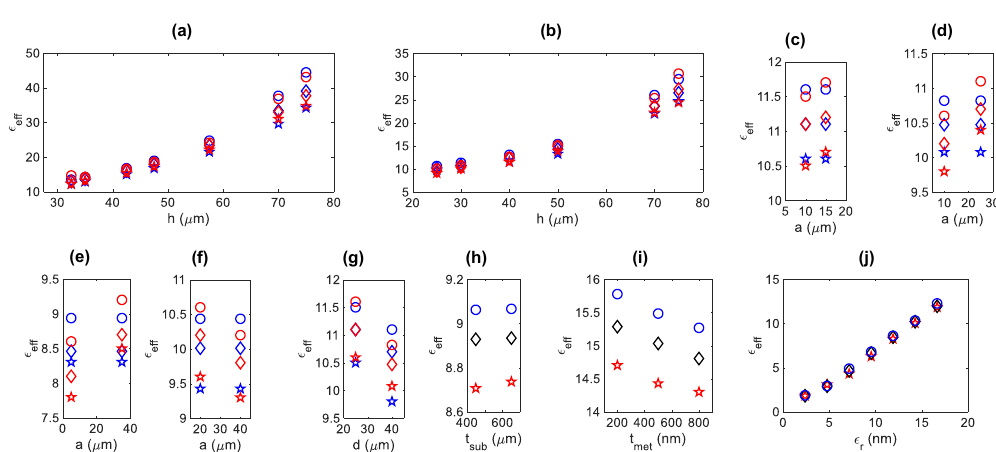
Figure 4. The comparison of measured and modelled effective dielectric constants: variation with respect to h (Set 1 and 2) ( a,b ), variation with respect to a (Set 3 to 6) ( c – f ) and variation with respect to d ( a = 10 μ m and h = 30 μ m) ( g ). The symbols in the figures correspond to the model at 0.25 THz ( ), 0.275 THz ( ) and 0.3 THz ( ), and measurements at 0.25 THz ( ), 0.275 THz ( ) and 0.3 THz ( ). The simulated variation of the effective dielectric constant with respect to substrate thicknesses (Set 7) ( h ), metal thickness (Set 9) ( i ) and relative permittivity (Set 8) (j ). The symbols in the figures of simulations correspond to 0.25 THz ( ), 0.275 THz ( ◊ ) and 0.3 THz (